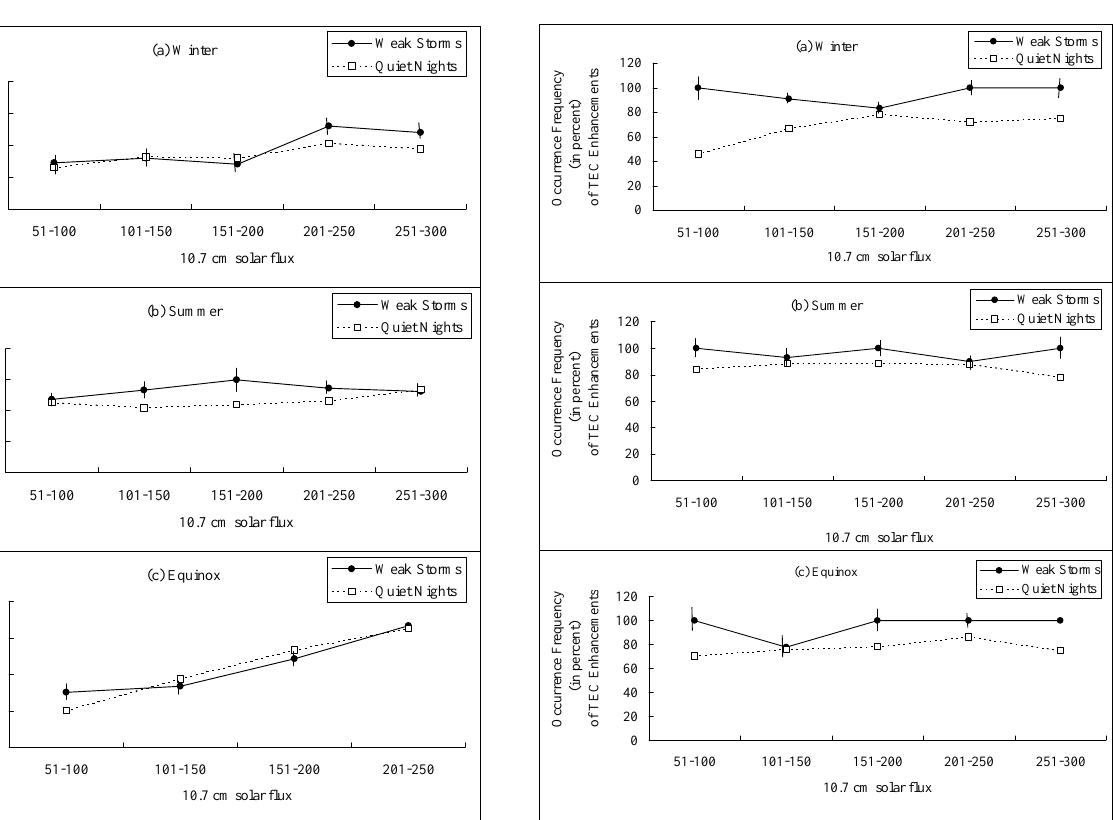
Fig. 4. The seasonal and solar activity variations of the occurrence frequency (in percent) of TEC enhancement during weak storms (solid curves) and quiet nights (dashed curves). The vertical bars represent the standard